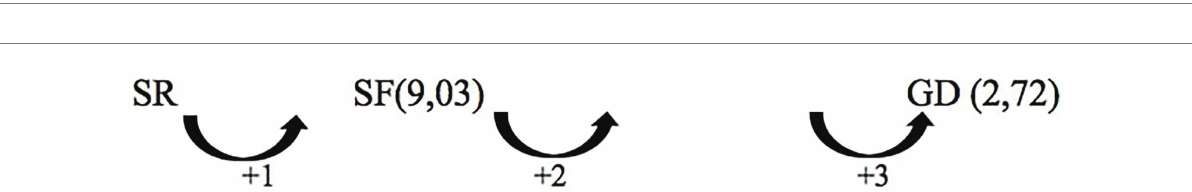
FIGURE 9 Association pattern between the focal conduct shot “R6mts” and the conditioned conduct attack result. “Efic” and opponent response “Rep” in all national teams. SR, no shot; SF, no finalization; GD, goal to goal attempt.